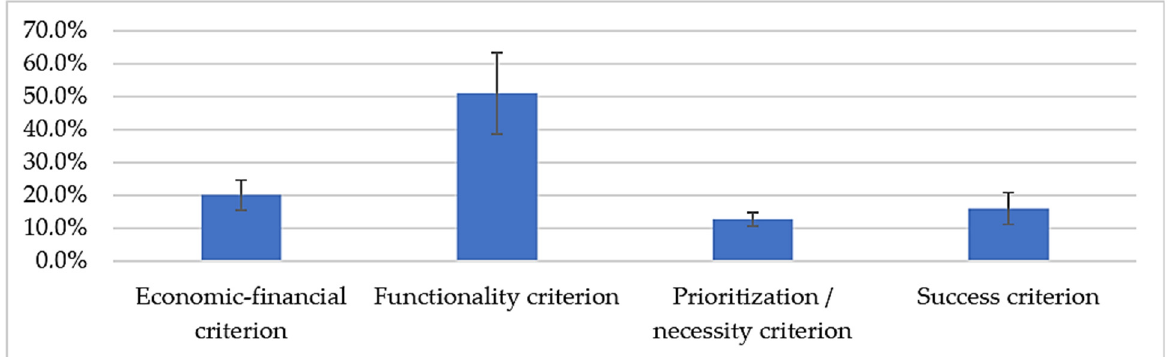
Figure 4. Graphic representation of results for the evaluated criteria—AHP